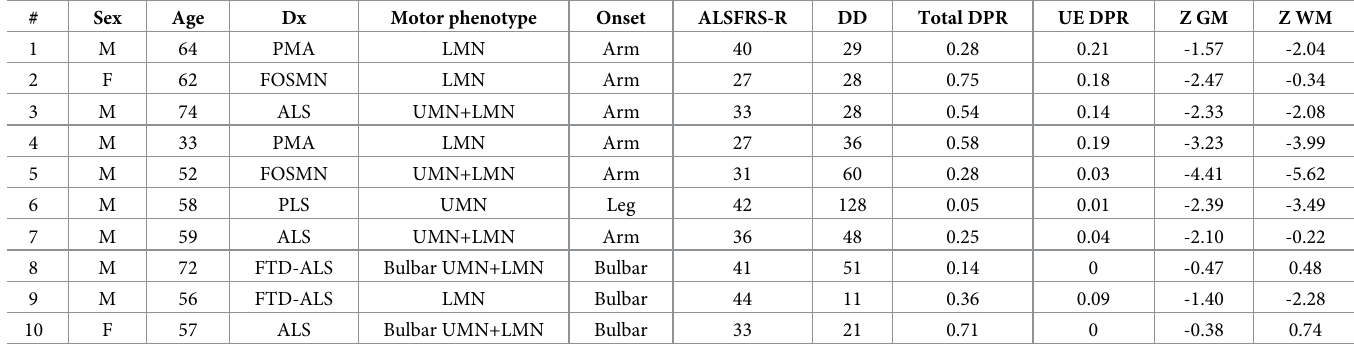
Table 1. Clinical characteristics and white and gray matter Z scores of patients with motor neuron disease.